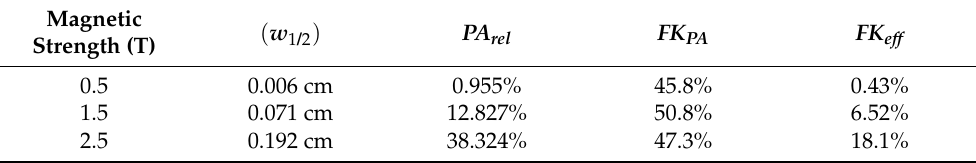
Table 7. Comparison of the calculated values of the treatment efficacy parameters for different magnetic strengths applied for a nanoparticle size of 100 nm after 60 min of IP injection. Magnetic Strength (T)